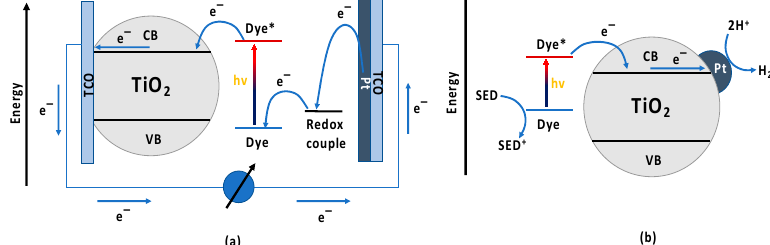
Figure 1. Energy levels and working mechanisms of: ( a ) dye-sensitized solar cells and ( b ) dye-sensitized Pt/TiO 2 photocatalysts.